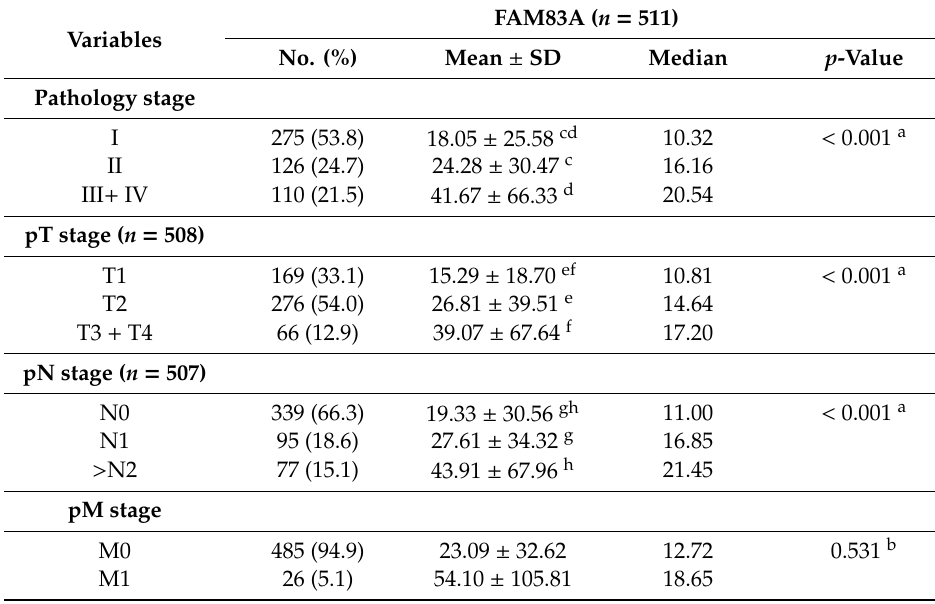
Table 2. Correlationof FAM83A expressionwithclinicopathologicalcharacteristicsoflungadenocarcinoma patients